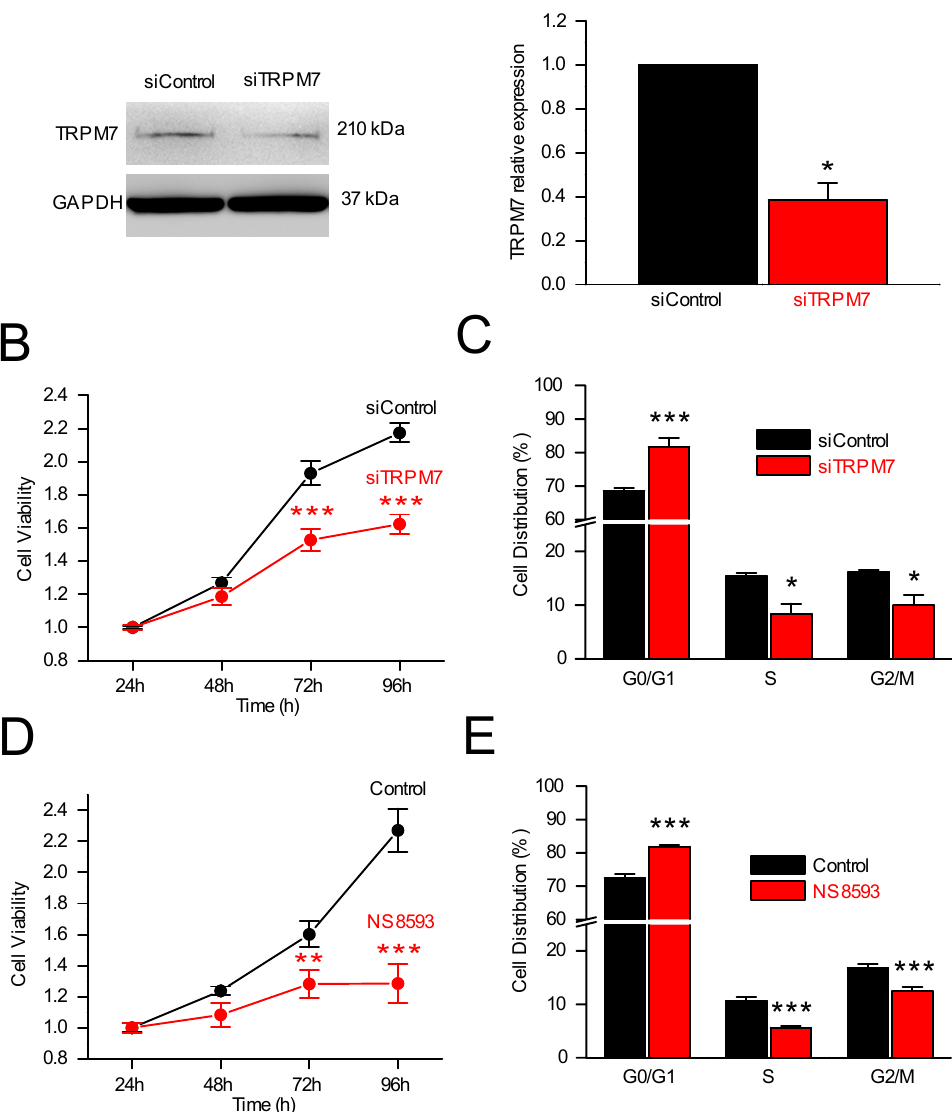
Figure 2. Proliferation was influenced by TRPM7 expression. ( A ) Immunoblotting of lysates of PS-1 cells transfected with a scramble siRNA (siControl) or a siRNA targeting TRPM7 (siTRPM7), and incubated with anti-TRPM7 antibody ( n = 4). * indicates p < 0.05 (Mann–Whitney Rank Sum Test). ( B ) PSC viability was decreased at 72 h and 96 h following TRPM7 silencing ( n = 4). *** indicates p < 0.001 (2 − ways ANOVA). ( C ) TRPM7 silencing led to enrichment of cells in G0/G1 while decreasing the percentages of cells in S and in G2/M phases of the cell cycle ( n = 3). * indicates p < 0.05 and *** indicates p < 0.001 (2 − ways ANOVA). ( D ) The pharmacological blocker of TRPM7 channels, NS8593 (25 µM), decreased PS-1 cell viability at 72 and 96 h ( n = 3). ** indicates p < 0.01 and *** indicates p < 0.001 (2 − ways ANOVA). ( E ) Following NS8593 treatment, PS-1 cells accumulated in G0/G1 phase, whereas the percentage of cells decreased in S and in G2/M phases ( n = 3). *** indicates p < 0.001 (2 − ways ANOVA).